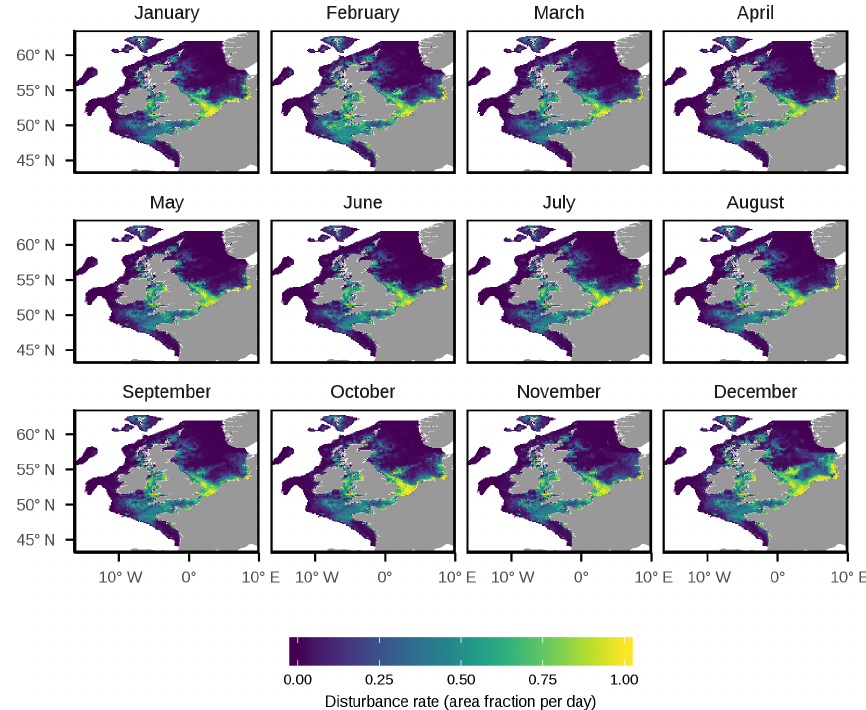
Figure 11. Modelled monthly disturbance rate. A disturbance event was defined as a time when the bed shear stress exceeded the threshold required to move either the mud, sand or gravel portion of the sediment. The monthly disturbance rate was defined as the mean fraction of the total mud, sand and gravel area disturbed per